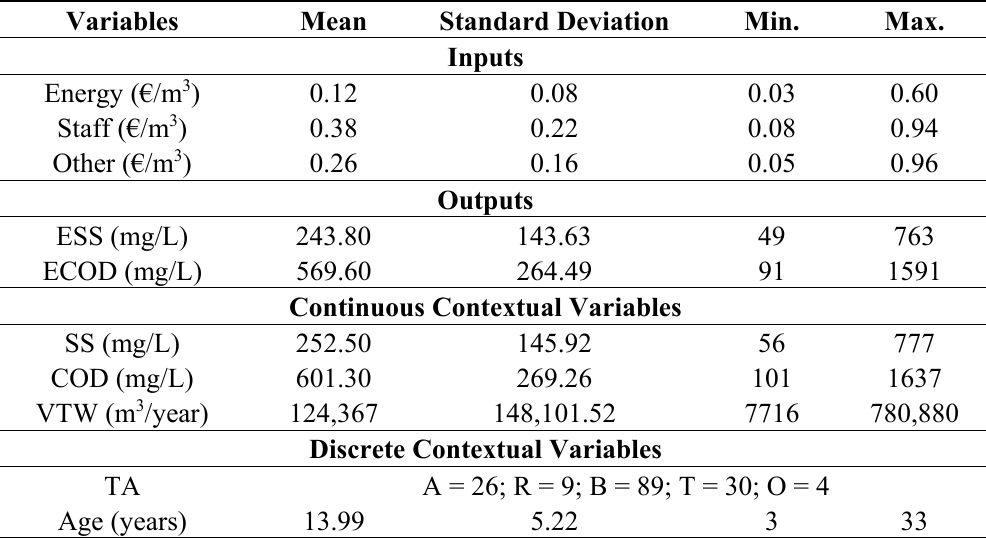
Table 2. Descriptive